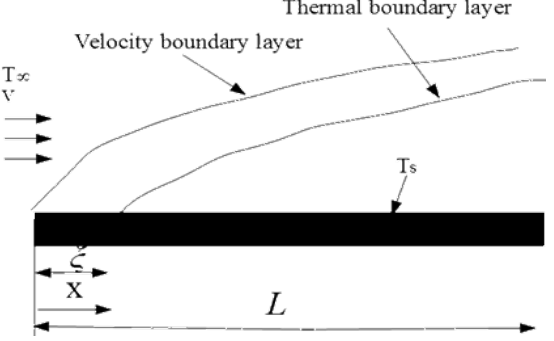
Fig. 1. Illustration of the coolant flows over a flat plate with an unheated